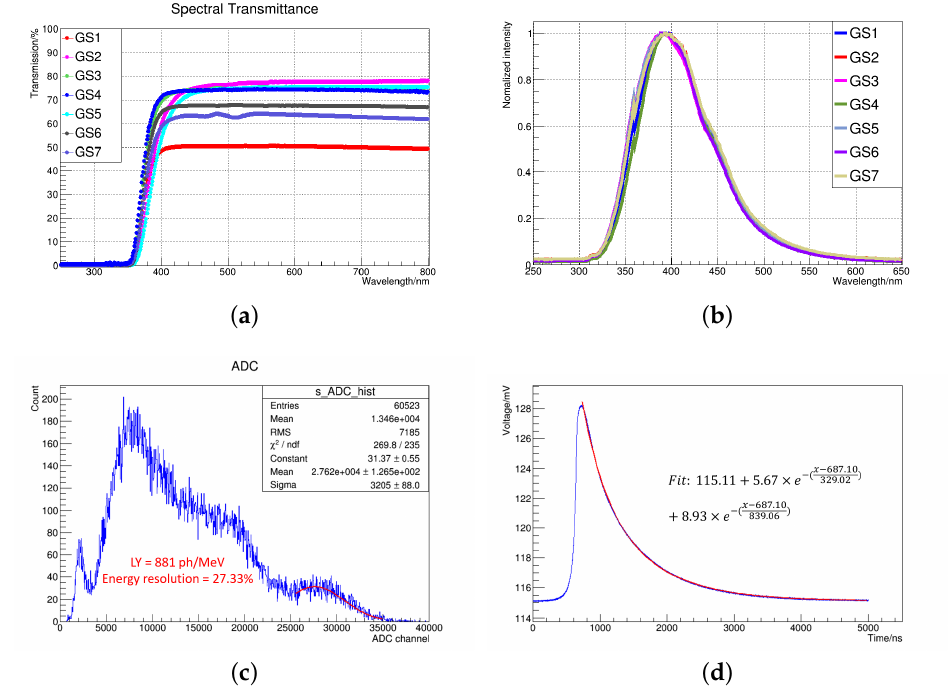
Figure 7. The partial measured results of aluminoborosilicate glass samples. ( a ) Transmission spectra of samples #1–#7; ( b ) normalized X-ray-excited luminescence emission spectra for samples #1–#7; ( c ) the energy spectra of sample #7 under a 137 Cs (662 keV) radioactive source; ( d ) scintillating decay time of sample #7.